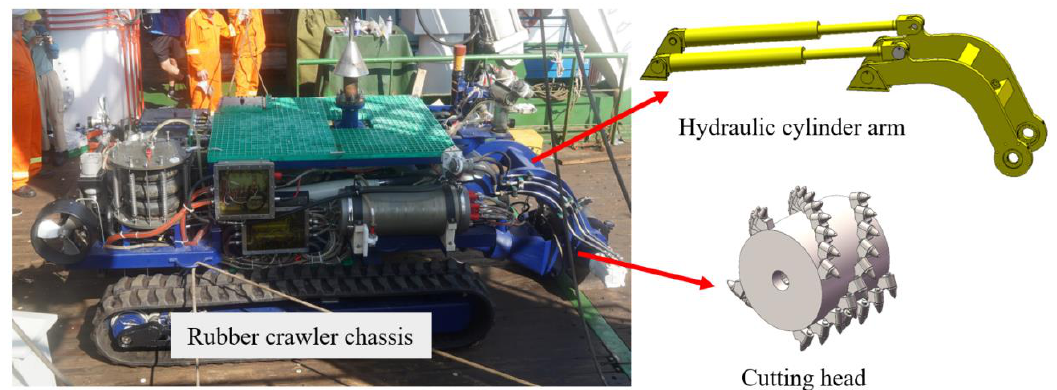
Figure 14. Structure diagram of mining vehicle. Table 5. Parameters of mining